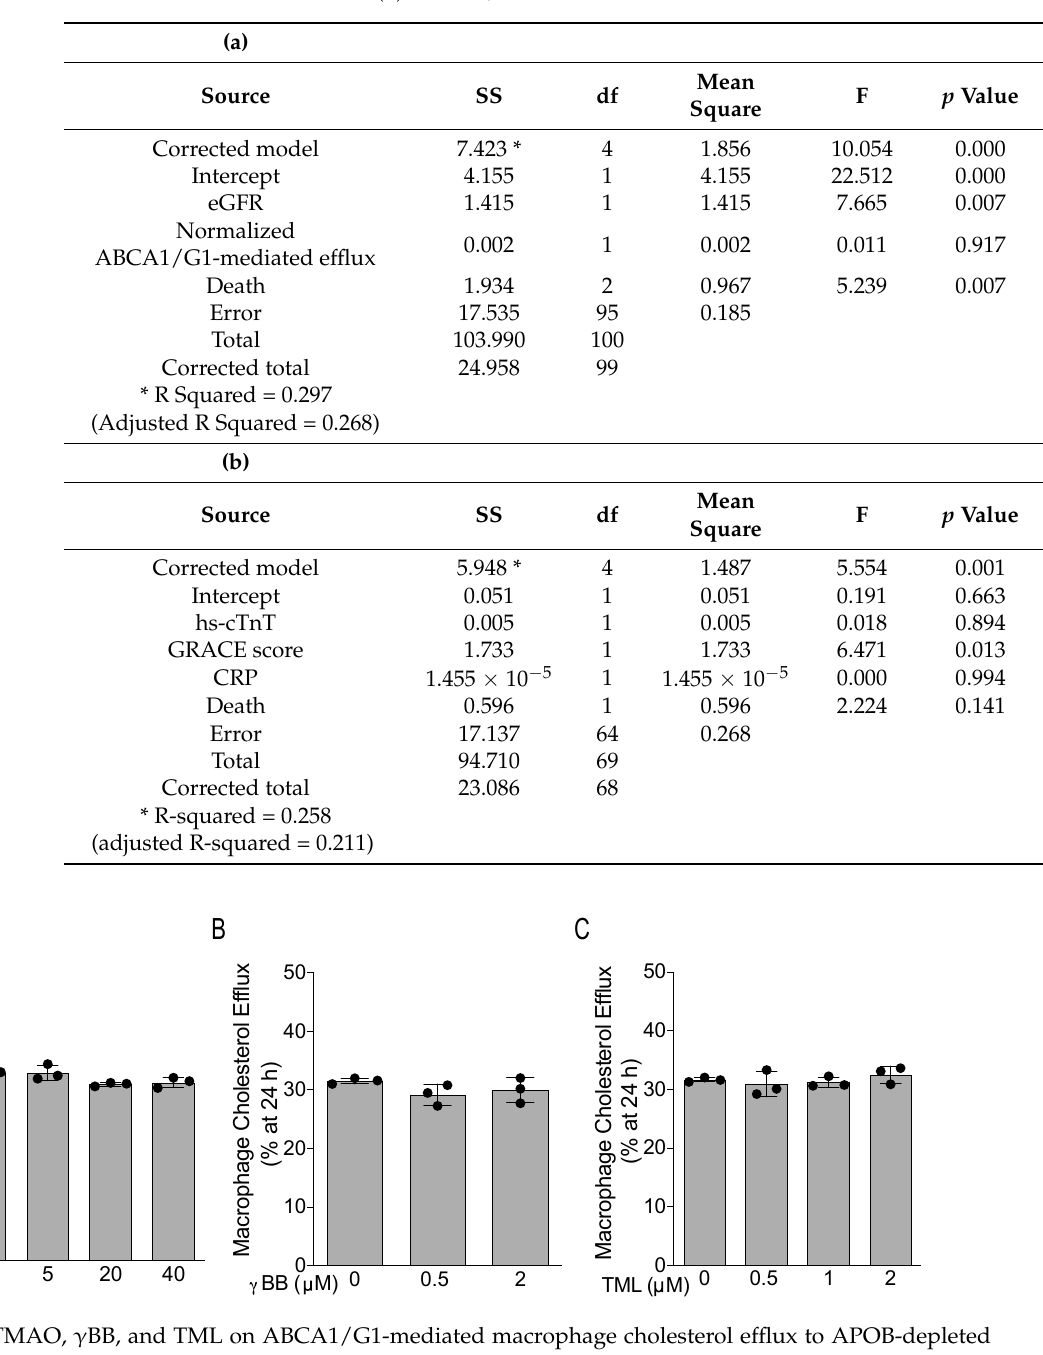
Table 3. Analysis of ANCOVA of circulating TML levels adjusted for (a) eGFR and normalized